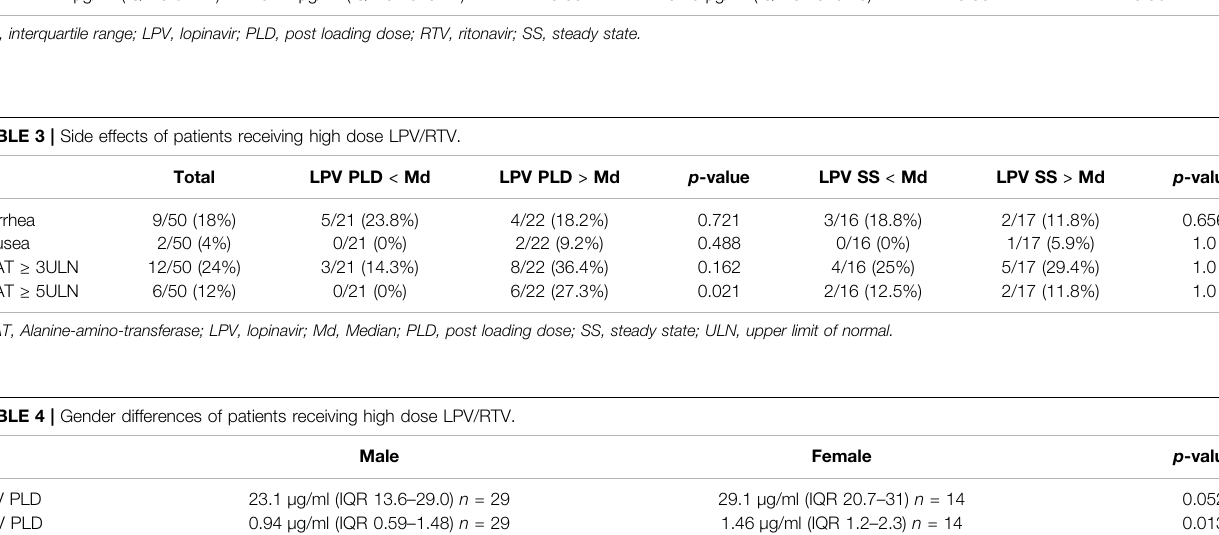
IQR, interquartile range; LPV, lopinavir; PLD, post loading dose; RTV, ritonavir; SS, steady state.